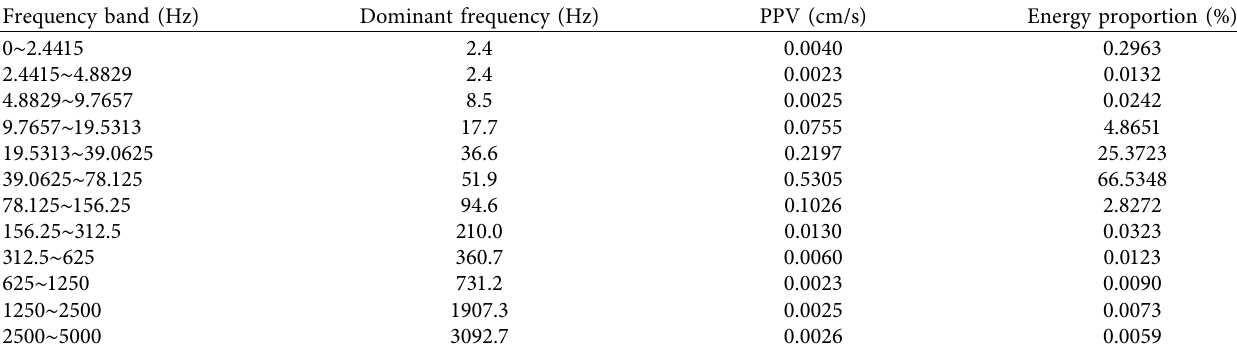
Table 7: Dominant frequency, PPV, and energy proportion of each subfrequency band at measuring point 10 in the near zone. Frequency band